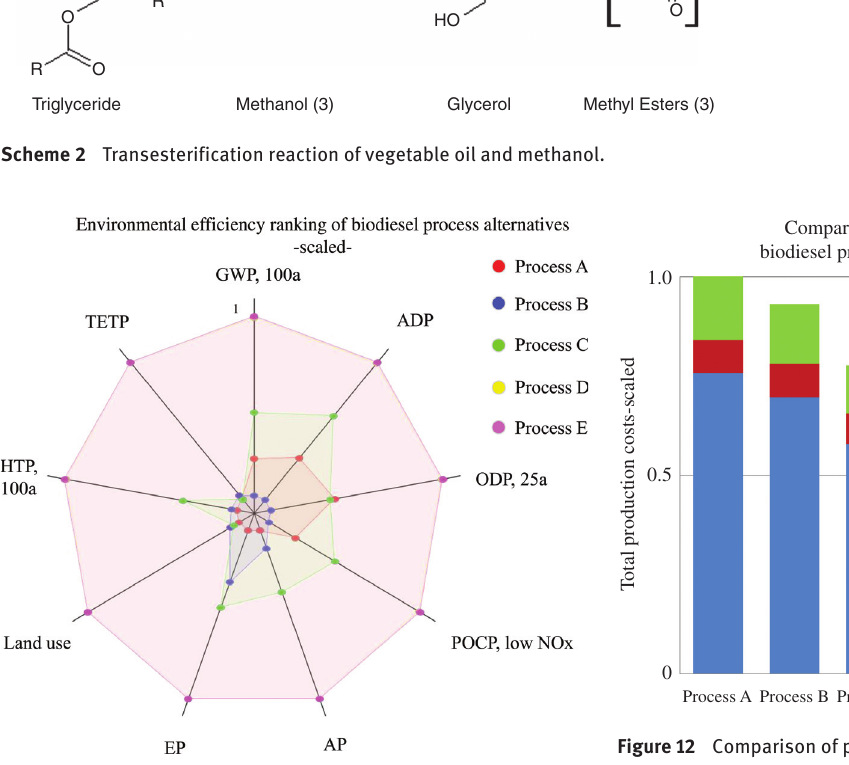
Figure 11 Multi-criteria outranking of different biodiesel process alternatives utilizing waste vegetable oil (Process A: pretreated alkali-catalyzed; Process B: acid-catalyzed; Process C: heteroge- neous acid-catalyzed; Process D: supercritical process, mass and energy flows considered according to West et al. [42] and Process E: supercritical process developed within CoPIRIDE) concerning envi- ronmental efficiency, taking into account several life cycle impact assessment (LCIA) categories.